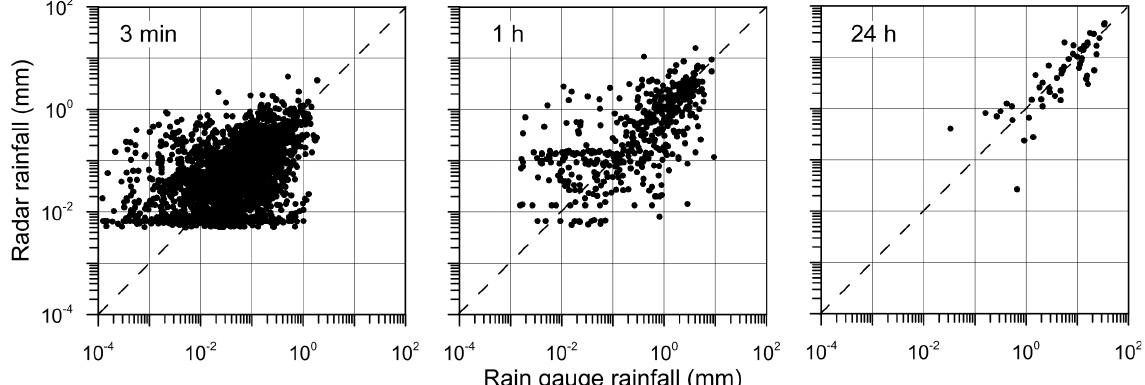
Fig. 2. Scatter plots of synchronous radar and rain gauge observations for 3min (radar data are transected along the lower 0.1mmh − 1 rainfall intensity threshold), hourly and daily intervals. The radar rainfall data represent the averaged rainfall derived from the 12 radar pixels. Dashed line represents a perfect fit between gauge and radar rainfall.